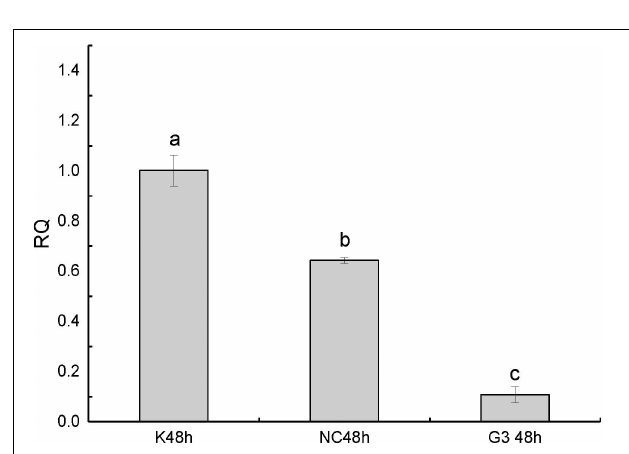
FIGURE 7 | qRT-PCR of PtDMY following 48 h of RNAi. K48, Blank control without any treatment; NC48, Inject a meaningless chain; G3, Inject interference to knock down the PtDMY. Means with different letters are significantly different ( P <